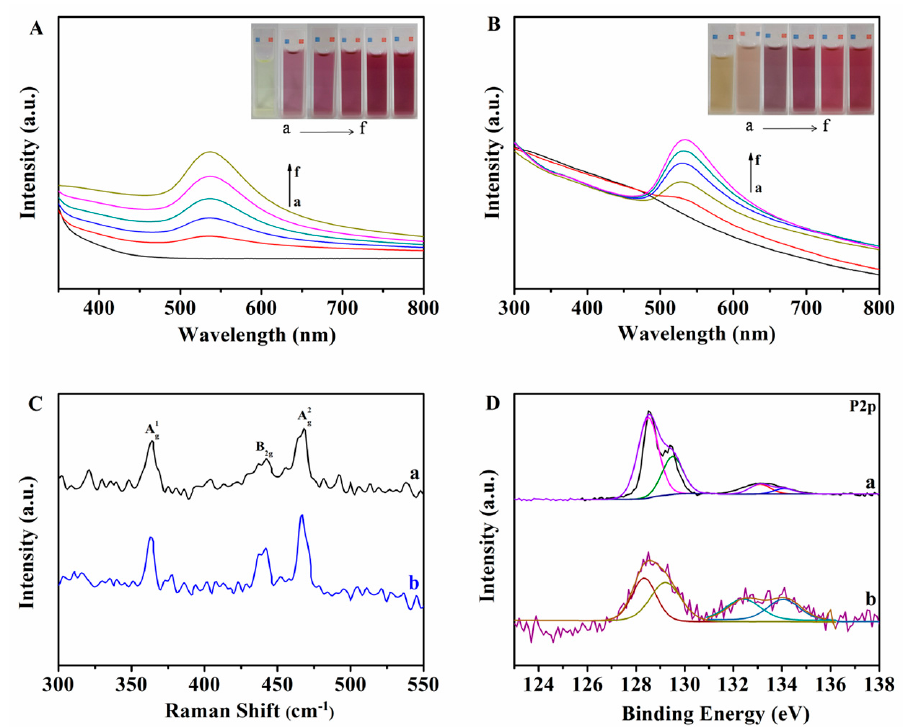
Figure 3. ( A ) UV–Vis spectrum of HAuCl 4 mixed with BPNS at different amounts (from a to f: 0, 0.2, 0.4, 0.6, 0.8, 1 mg/mL). ( B ) UV–Vis spectrum of HAuCl 4 added to BPNS for different times (from a to f: 0, 15, 30, 40, 50, 60 min). ( C ) Raman spectra of BPNS (curve a) and AuNPs–BPNS (curve b). ( D ) High-resolution XPS spectra of the P2p core level for BPNS (curve a) and AuNPs–BPNS (curve